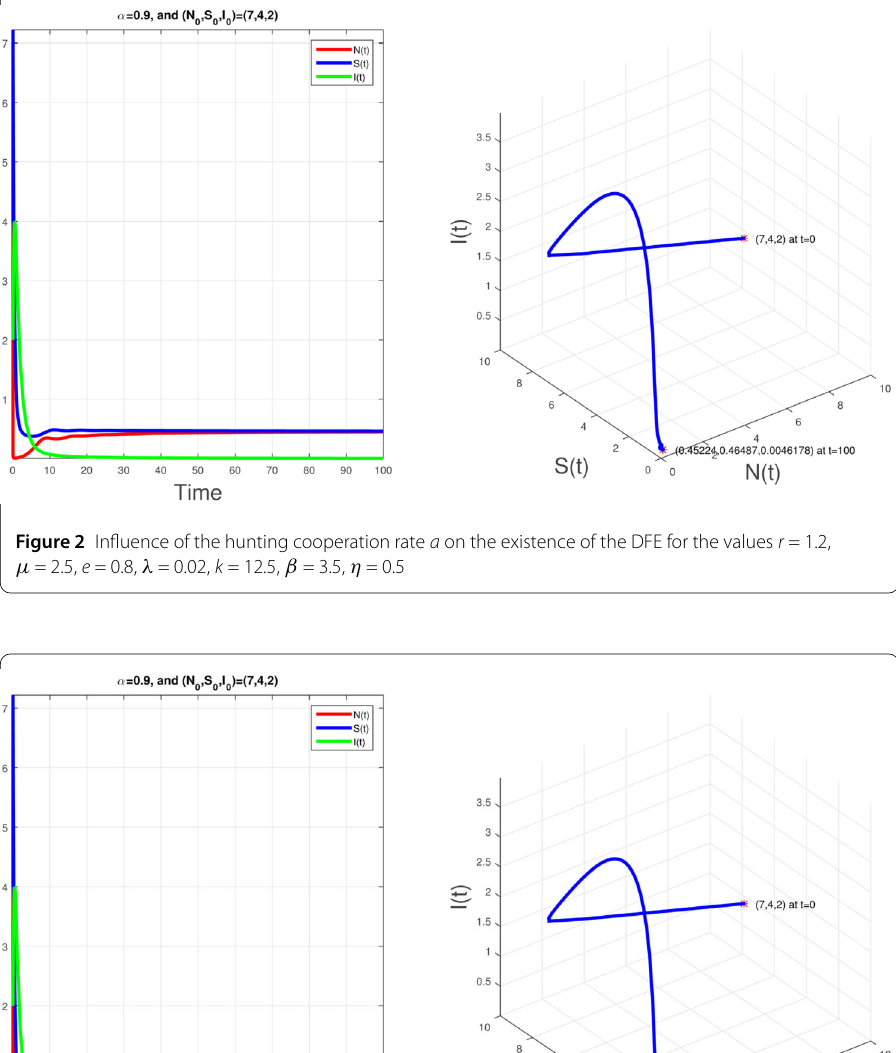
Fig. 4: In this figure we have the instability of the DFE and the existence of oscillations in time. The following values (cid:9) 5 = (0.27,0.64,0.11) , where the following values α = 0.9 , r = 3.2 , k = 10.5 , μ = 2.5 , e = 0.5 , λ = 1.5 , a = 3.5 , β = 1.5 , η = 0.5 are considered. Fig. 5: This figure shows the stability of the EE (cid:9) 5 = (0.27,0.64,0.11) where the following values α = 0.9 , r = 3.2 , k = 10.5 , μ = 0.5 , e = 0.5 , λ = 1.5 , a = 3.5 , β = 1.5 , η = 0.5 are used. Fig. 6: The persistence of the three populations in the case of the instability of the EE, the following values α = 0.9 , r = 5.2 , k = 30.5 , λ = 1.5 , μ = 2.5 , e = 0.8 , a = 4.5 , β = 3.5 , η = 0.5 are